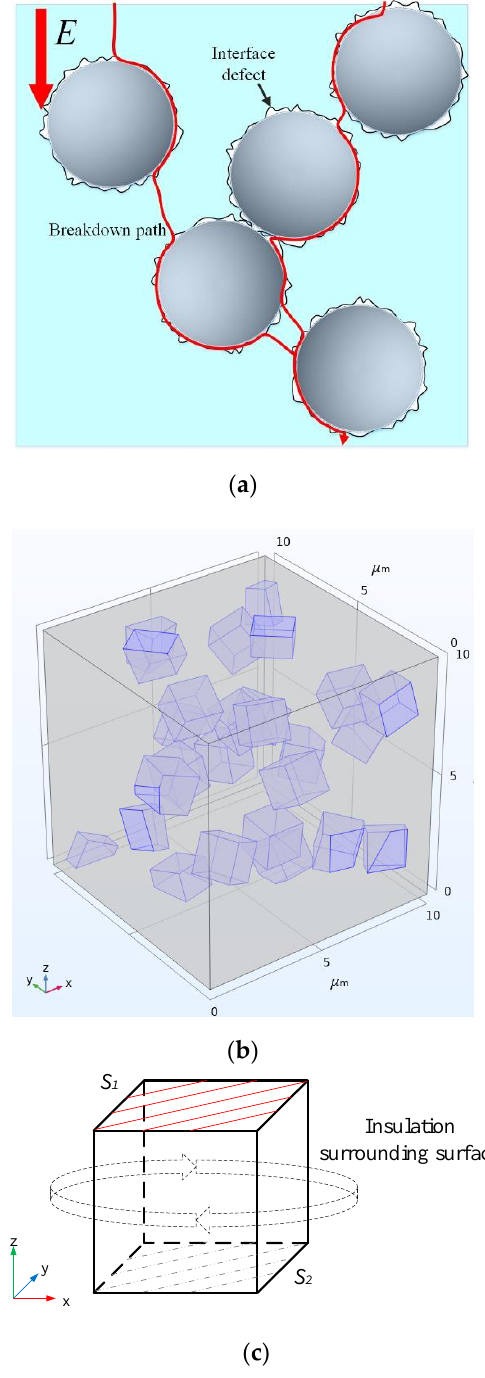
Figure 6. ( a ) Schematic diagram of micro-filler/matrix interface defects; ( b ) RVE model of composite material; ( c ) Schematic diagram of boundary condition setting.